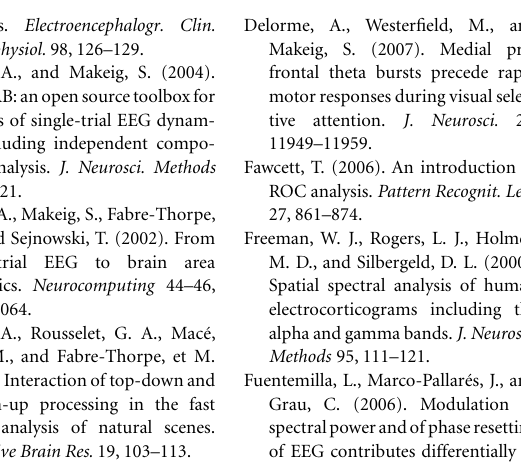
FIGURE 11 | Mean percentage of significant pixels during the baseline period for ERSP z , ERSP FullTB − z , ERSP % , and ERSP FullTB − % using the two statistical methods. ERSPs were all computed on electrode Iz and averaged over 14 subjects.The bootstrap random polarity inversion statistical method is shown on the left column and the baseline permutation statistical method is